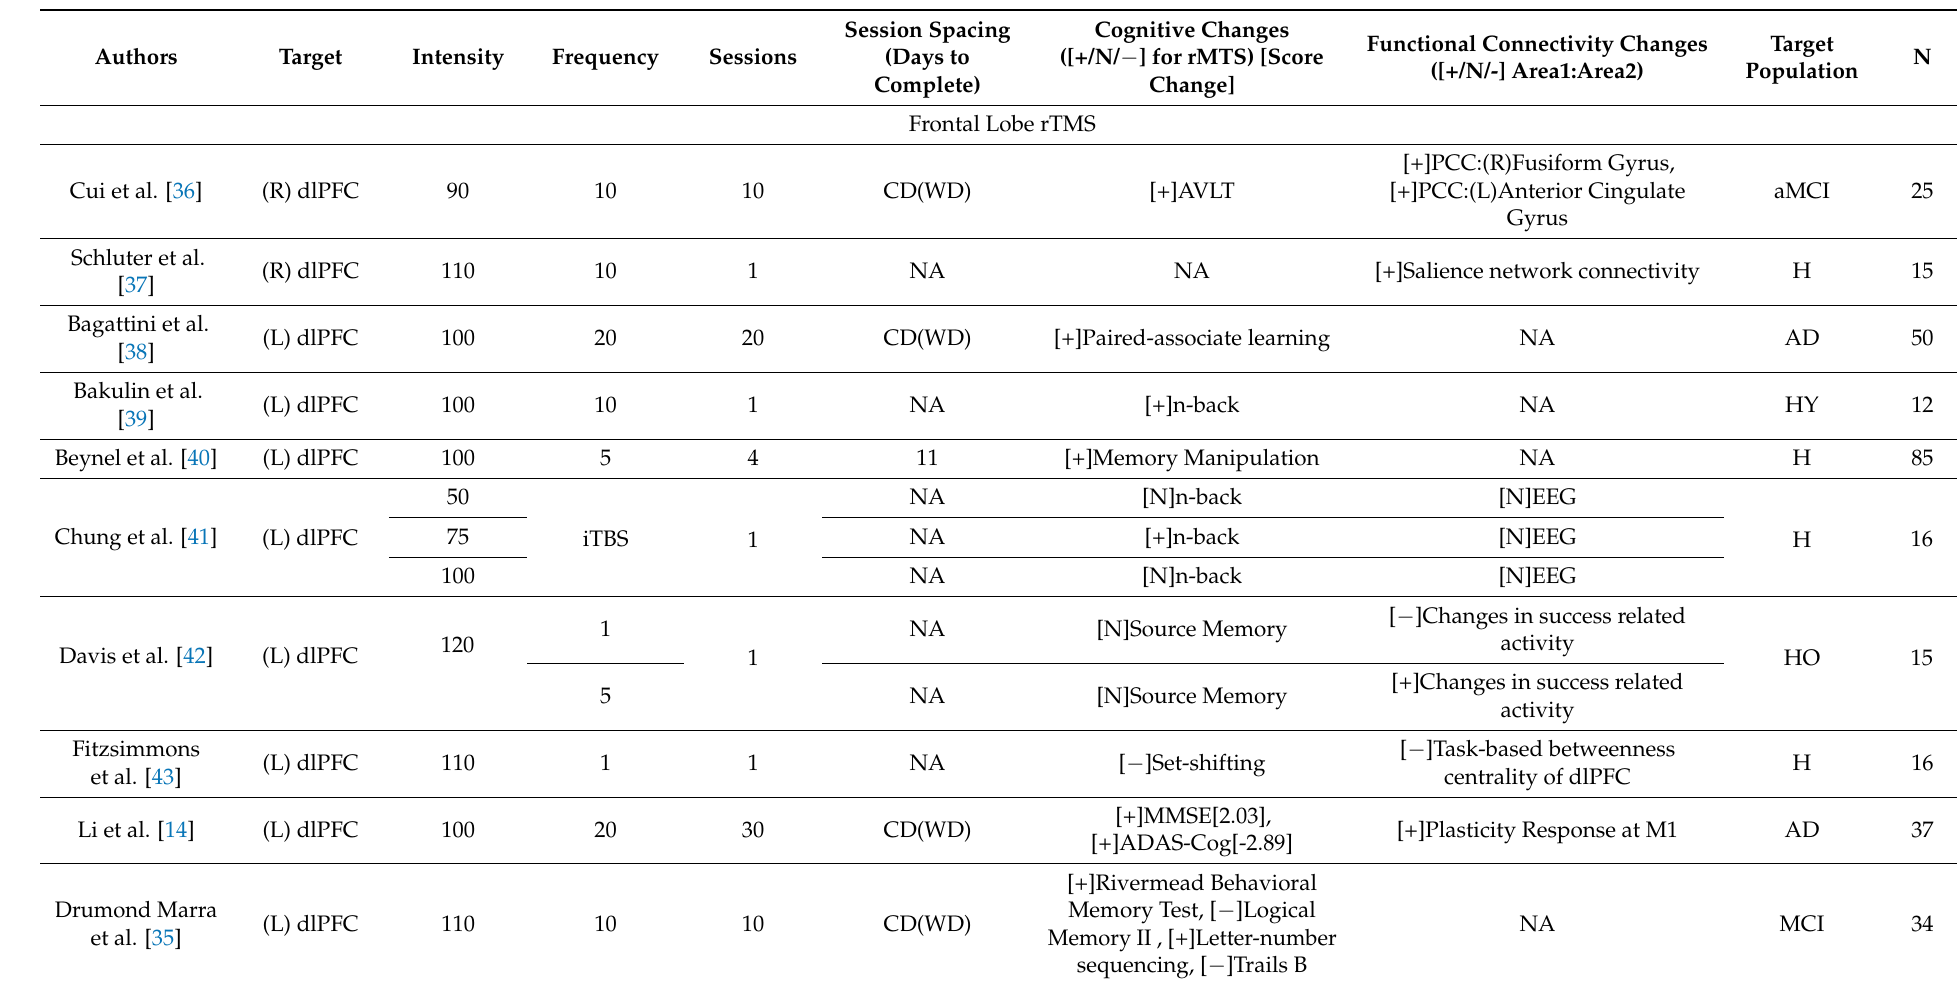
Table 1. Properties of included